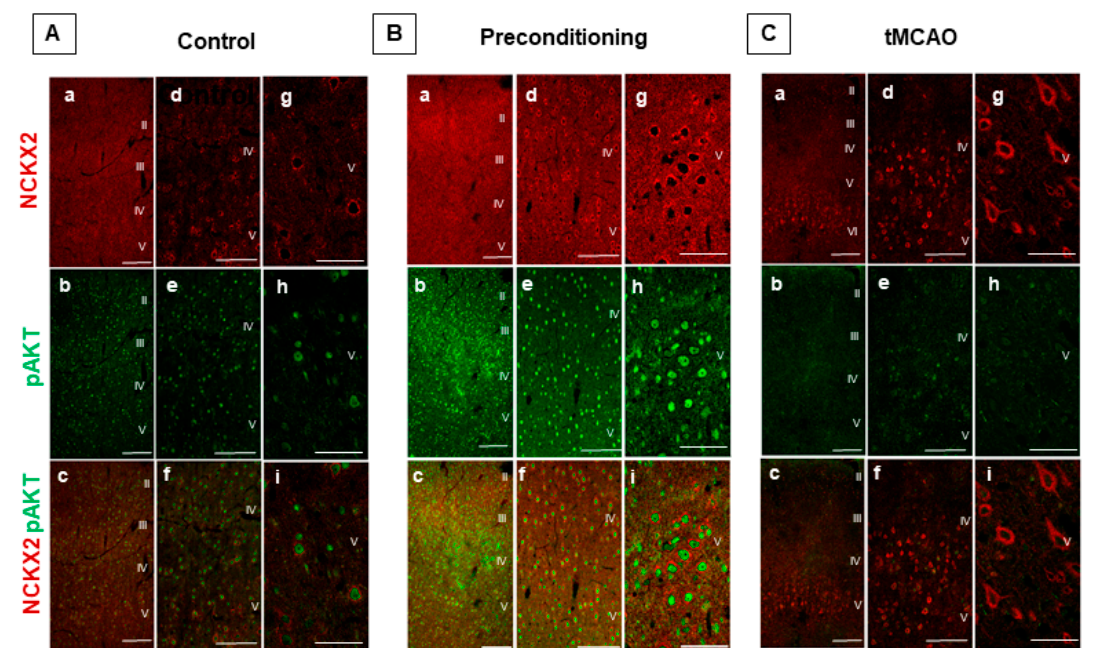
Figure 2. COEXPRESSION OF NCKX2 AND pAKT IMMUNOREACTIVITIES IN THE PERIIS- CHEMIC CORTICAL REGION OF PRECONDITIONED AND ISCHEMIC RATS. ( A – C ), Repre- sentative images displaying the co-expression of NCKX2 with pAKT immunoreactivities in the temporoparietal cortex of control ( A ), preconditioned ( B ) and ischemic animals ( C ). Reperfusion time was 72 h both in preconditioned and ischemic animals. Panels a–c, d–f and g–i were acquired at increasing magnification of 10×, 20× and 50×, respectively. Higher magnification images were taken in the deep cortical layers. Scale bars in a–c: 200 μ m, in d–f: 100 μ m, in g–i: 50 μ m. As observed in the temporoparietal cortex, the preconditioning stimulus intensely increased pAKT, but not NCKX2 signal in the striatum. In this region, pAKT was clearly detected in fiber bundles, in which NCKX2 was not detected (Figure 3).